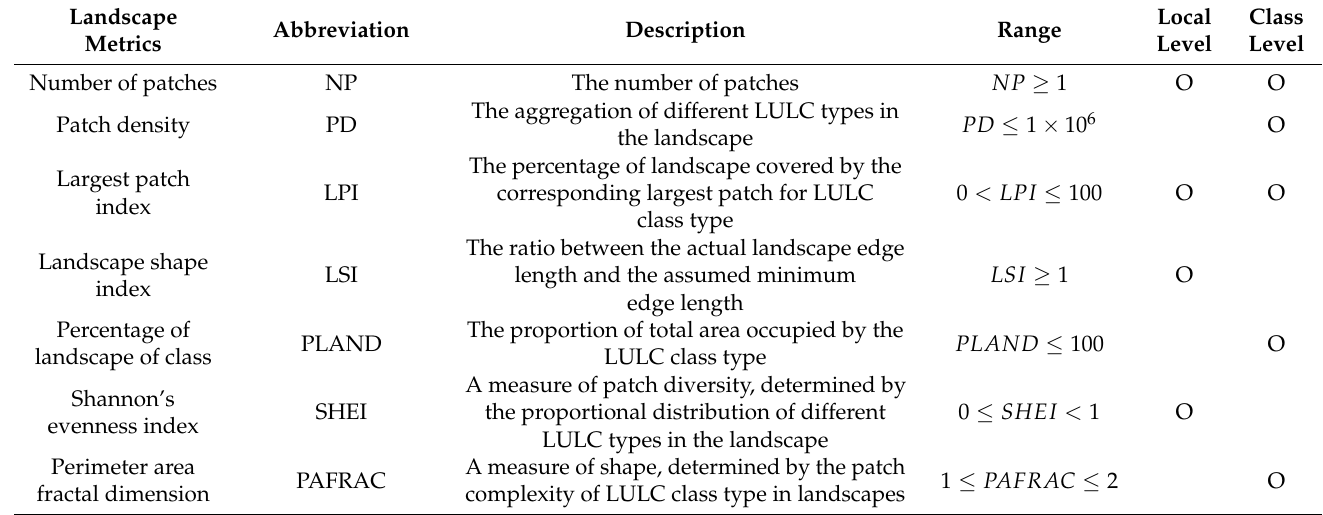
Table 2. Landscape metric type information used at the local and class levels in